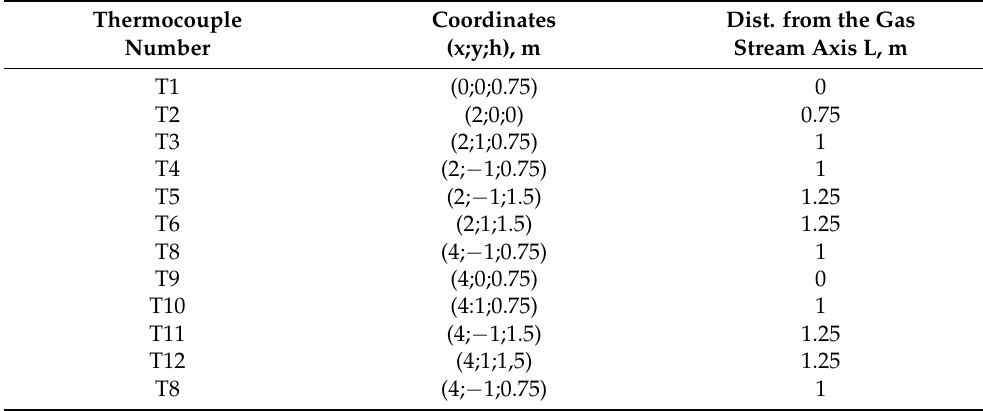
Table 2. Coordinates of thermocouples (x;y;h) and their distance from the gas stream